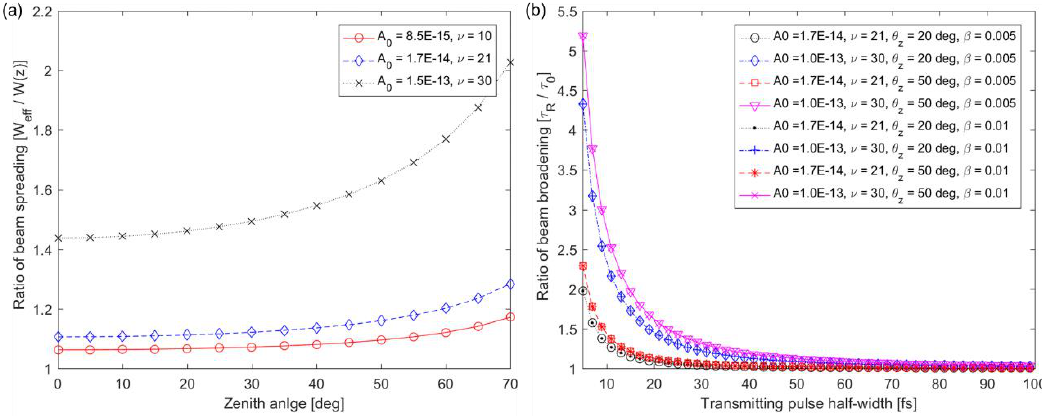
Figure 3. ( a ) Beam spreading and ( b ) broadening, due to the atmospheric turbulence.